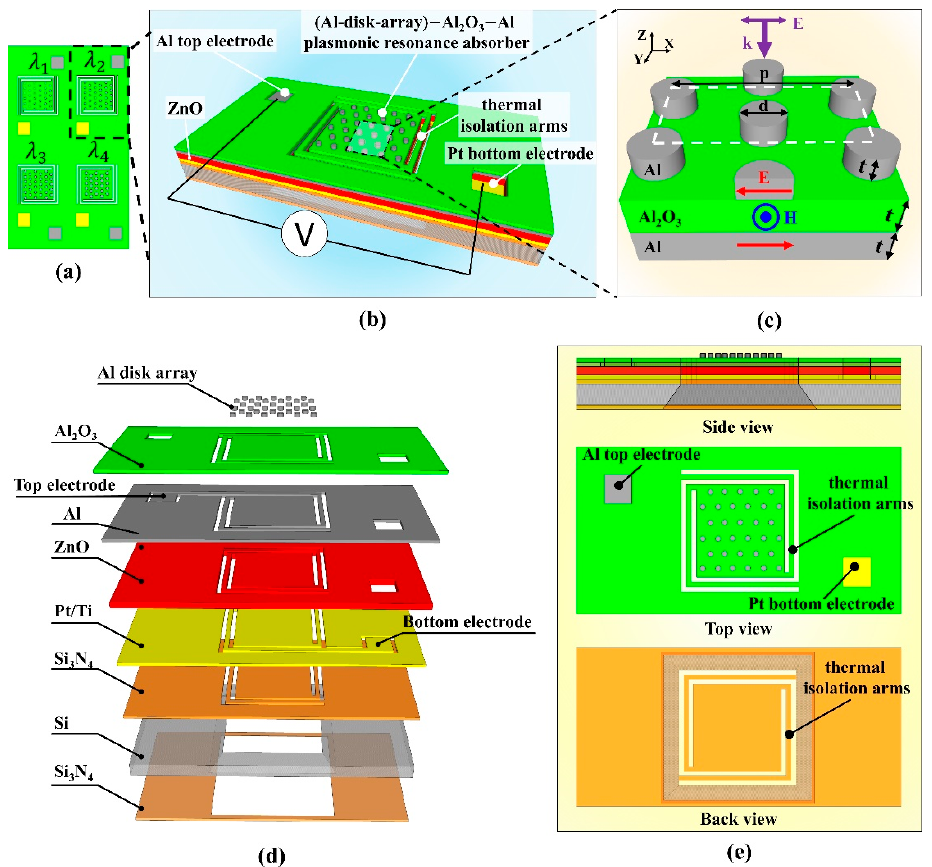
Figure 1. ( a ) Schematic illustration of the proposed quad-wavelength detector. ( b ) Illustration of the structural design of a single sensing element. ( c ) Illustration of the plasmonic perfect absorber with the indicated field lines at resonance (electric field E, red arrows; magnetic field H, blue arrows). ( d ) Exploded view of a single sensing element. ( e ) Side view, top view, and bottom view of a single sensing element.